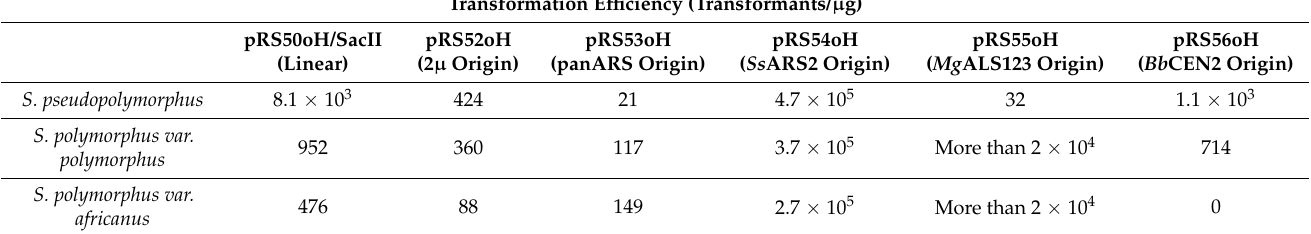
Table 3. Transformation efficiencies obtained during a typical transformation of yeasts from the Schwanniomyces genus with linearized integrative plasmid and replicative plasmids carrying various replication origins. Control samples where no DNA was added in the transformation mixture did not yield any